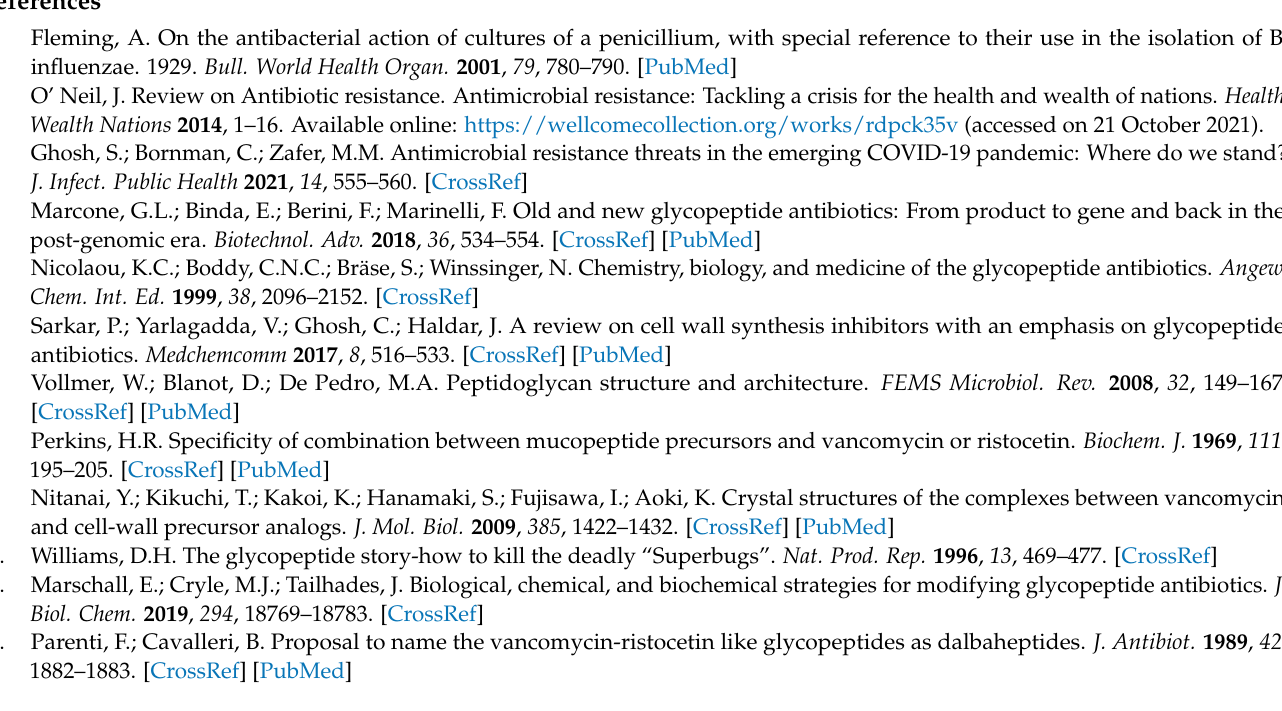
Figure S19, Expanded version of the VS1 cluster from the phylogenetic tree of actinobacterial VanS- like sensor histidine kinases; ESM Figure S20, Expanded version of the Dbv6-like cluster from the phylogenetic tree of actinobacterial VanR-like response regulators; ESM Figure S21, Expanded version of the Dbv22-like cluster from the phylogenetic tree of actinobacterial VanS-like sensor histidine kinases; ESM Figure S22, Expanded version of the VR4 cluster from the phylogenetic tree of actinobacterial VanR-like response regulators; ESM Figure S23, Expanded version of the VS3 cluster from the phylogenetic tree of actinobacterial VanS-like sensor histidine kinases; ESM Figure S24, Expanded version of the clade corresponding to the crown group of bacterial VanR response regulators; ESM Figure S25, Expanded version of the crown group of bacterial VanS-like sensor histidine kinases; ESM Figure S26, Expanded versions of the VR5-7 clusters of the phylogenetic tree from ESM Figure S24; ESM Figure S27, Expanded version of the VS4 cluster of the phylogenetic tree from ESM Figure S25; ESM Figure S28, Expanded version of the VS5 cluster of the phylogenetic tree from ESM Figure S25; ESM Figure S29, Expanded version of the VS6 cluster of the phylogenetic tree from ESM Figure S25; ESM Figure S30, Expanded version of the VS7 cluster of the phylogenetic tree from ESM Figure S25; ESM Figure S31, Expanded version of the VS8 cluster of the phylogenetic tree from ESM Figure